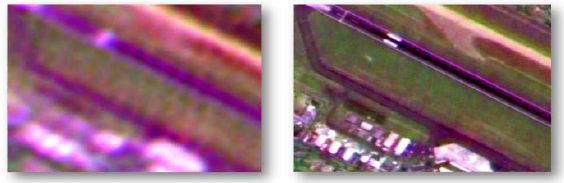
Figure 6 – TM images (3R4G2B), Goiânia Airport: Multispectral image (left) and hybrid image (right).